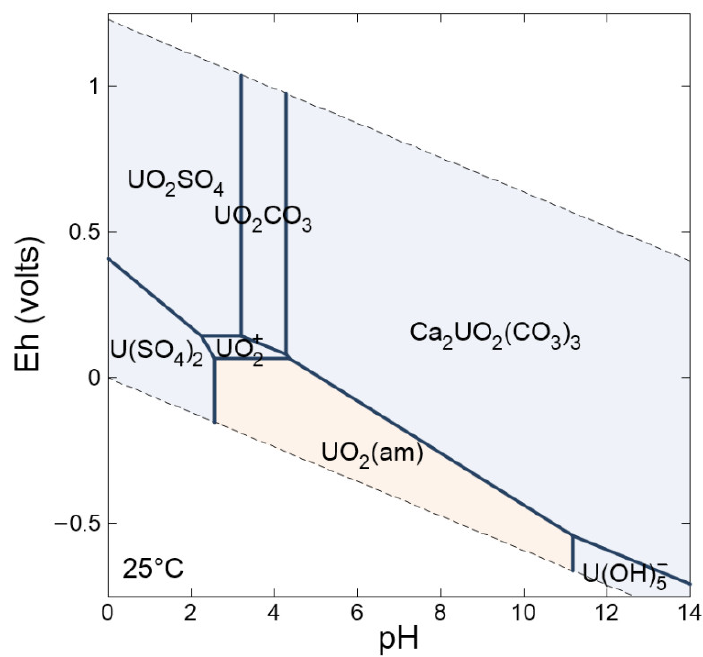
Figure A30. High uranium 10 mg/L, Ca 5 mM (200 mg/L), bicarbonate 7 mM (427 mg/L), sulfate 4 mM (384 mg/L), and chloride 2 mM (71 mg/L).